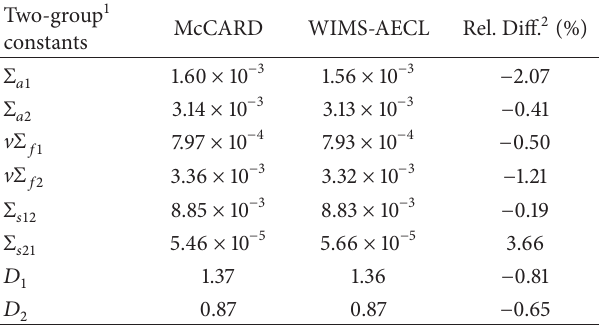
Table 2: Comparison of two-group constants generated by McCARD and WIMS-AECL for the depleted uranium fuel